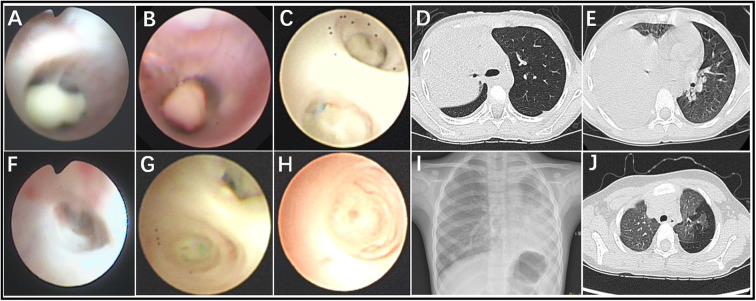
Fiberoptic bronchoscopy revealed mucous plug (A–C), airway stenosis (F), and airway obliteration (G,H), which suggested airway hyper secretion or airway obstruction in RMPP patients. Chest imaging revealed high-density consolidation on early stage (D,E) and bronchitis/bronchiolitis obliterans (I,J) on late stage in RMPP patients.